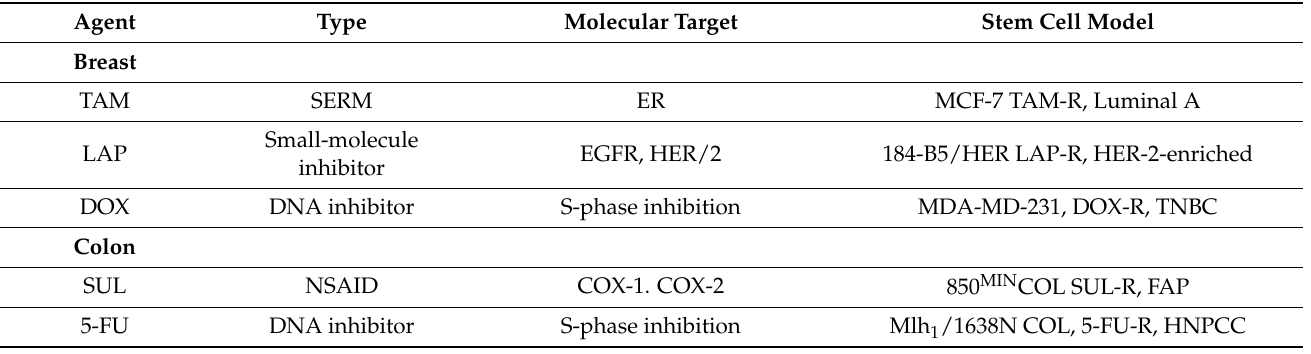
Table 4. Pharmacological agents for isolation of resistant